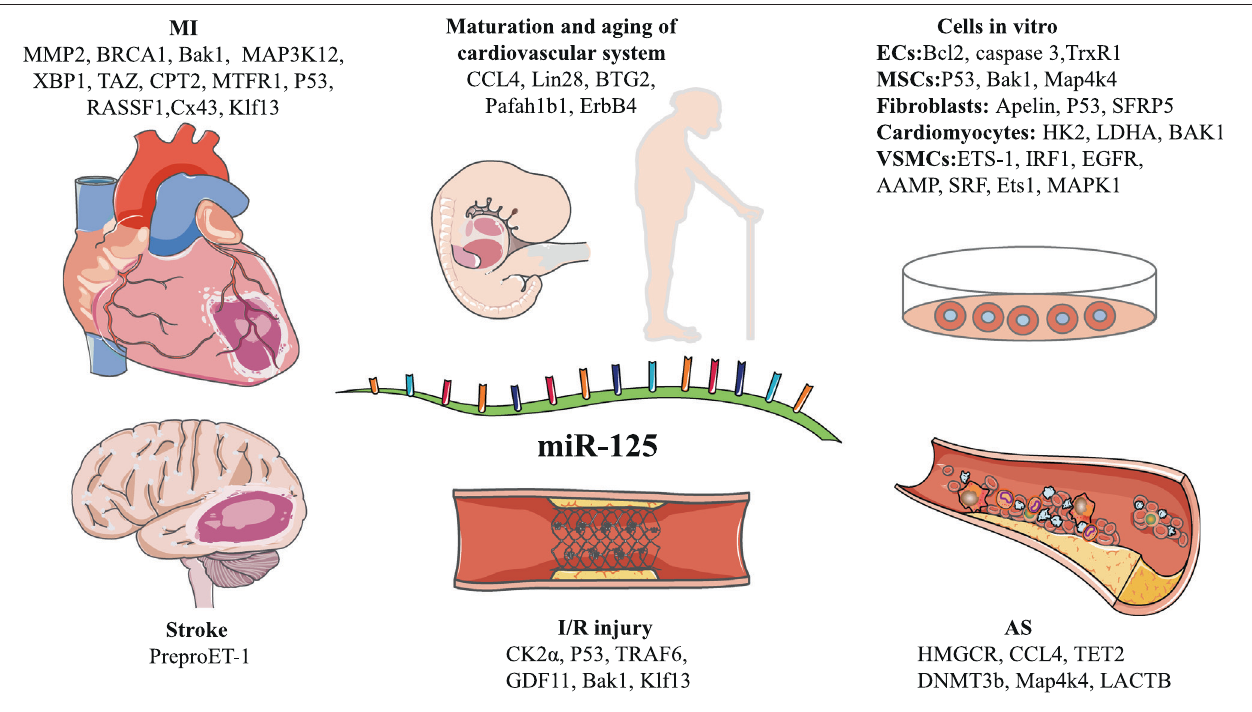
FIGURE 1 | Schematic diagram of the target genes of miR-125 family in different types of disease pathogenesis.